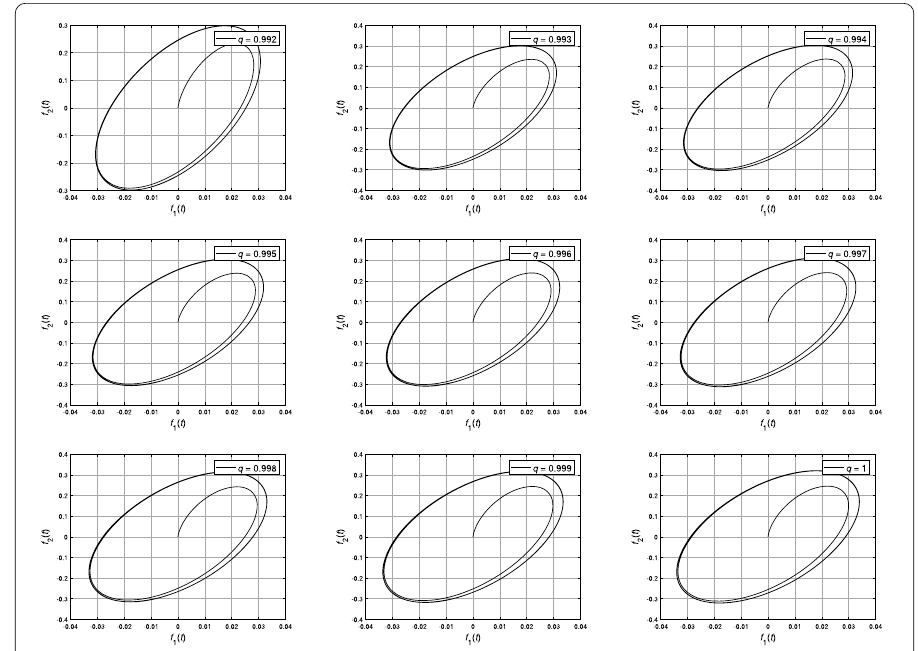
Figure 6 The phase-portraits of the controlled system (34) for q = 0.992,0.993,0.994,0.995,0.996,0.997,